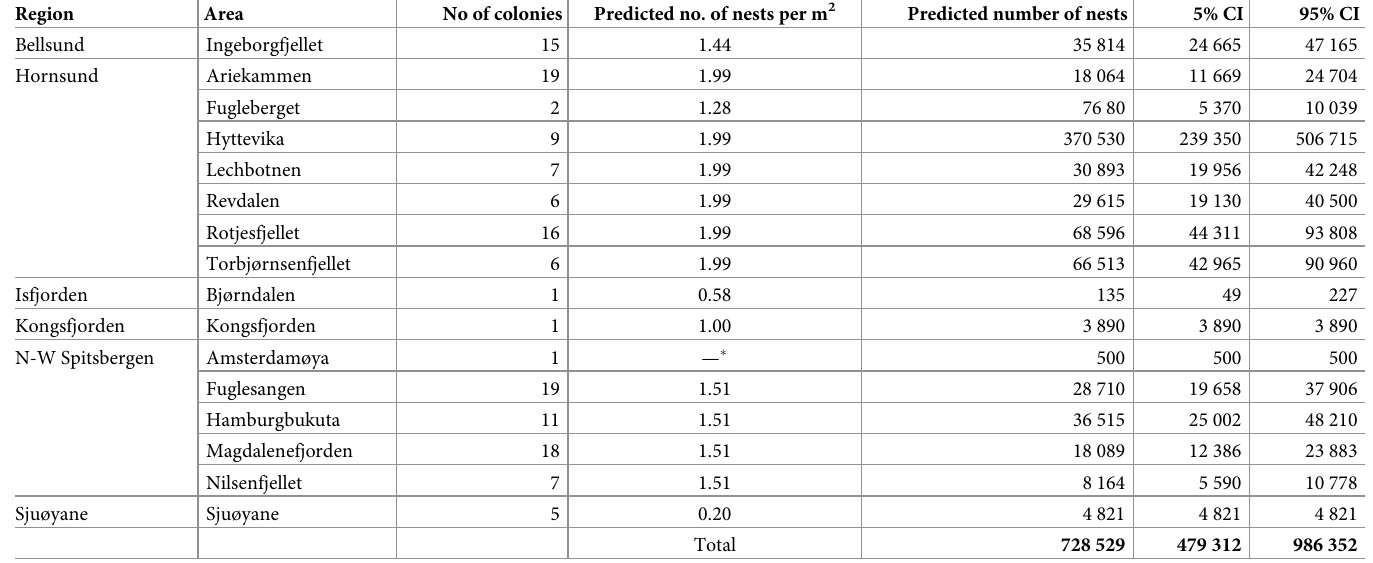
Table 3. The surveyed colonies, and predicted number of little auk pairs. CI–confidence interval.